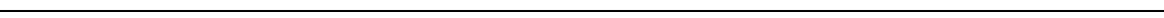
Fig. 4 Inter-subject similarities by social distance. a – c Average dyadic fMRI response time series similarities overlaid on a cortical surface model ( a lateral view; b medial view; c ventral view). In order to illustrate how relative similarities of responses in each brain region varied as a function of social distance, inter-subject time series similarities (i.e., Pearson correlation coef fi cients between preprocessed fMRI response time series) were normalized (i.e., z -scored across dyads for each region) prior to averaging across dyads for each brain region and overlaying results on an in fl ated model of the cortical surface for each social distance category. Warmer colors indicate relatively similar responses for a given brain region; cooler colors indicate relatively dissimilar responses for that brain region. Please note that because similarities have been normalized across dyads for each brain region, values depicted in this fi gure should be compared across social distance levels for each brain region, rather than across brain regions within or across social distances. Please see Fig. 3 for presentation of results that include subcortical gray matter structures. Ant. = anterior; Post. = posterior; L = left; R = right. d Deviation-coded point estimates and 95% CIs for weighted average neural similarities, after accounting for inter-subject similarities in control variables (demographic variables and handedness) are shown for distance 1 (deviation-coded point estimate = 0.23, 95% CI [0.07, 0.41]), distance 2 (deviation-coded point estimate = 0.03, 95% CI [ − 0.11, 0.17]), distance 3 (deviation-coded point estimate = − 0.20, 95% CI [ − 0.30, − 0.09]), and distance 4 (deviation-coded point estimate = − 0.07, 95% CI [ − 0.29, 0.14]) dyads. Deviation coding measures the difference in overall neural similarity between dyads within each social distance category and the average overall neural similarity of dyads in the other social distance categories, after removing the effects of control variables. For further details on deviation coding, please refer to the Supplementary Methods. Cortical surface visualizations were created using PySurfer